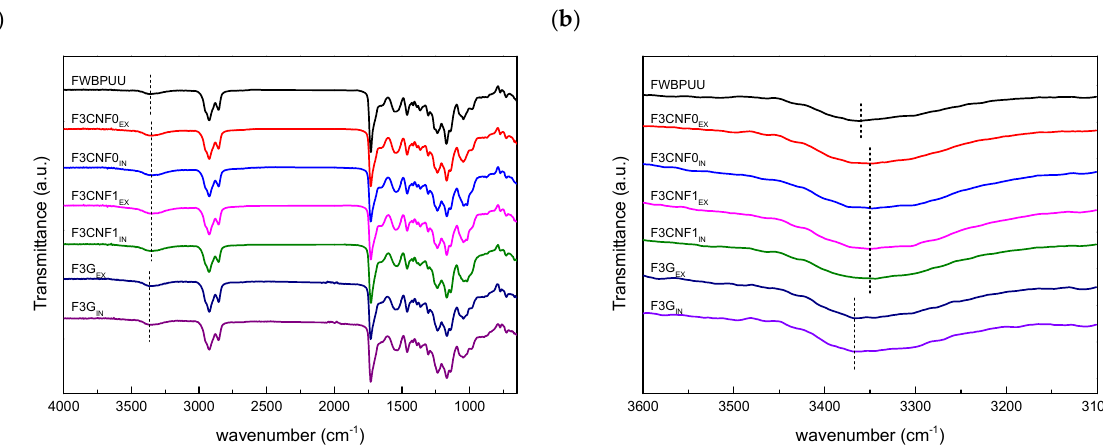
F3G IN Figure 5. Photographs of the prepared in-situ and ex-situ filaments. Fourier transform infrared spectroscopy analyses were carried out in order to assess possible interactions taken place between the WBPUU matrix and the nanoreinforcements used. FTIR spectra of WBPUU filament and composite filaments are shown in Figure 6. FWBPUU spectrum shows characteristic bands of polyurethanes: an absorption band corresponding to H-bonding of polyurethanes’ N–H groups at 3360 cm −1 , a band at- tributed to carbonyl vibration of the polyol and urethane groups at 1730 cm −1 , bands at 1645 cm −1 and 1545 cm −1 , assigned to carbonyl stretching vibration of the urea groups, and C–N stretching vibration and N–H bending of urethane and urea groups, respectively, and bands in the 1250–1000 cm −1 region corresponding to C–O stretching vibrations [59– 61].